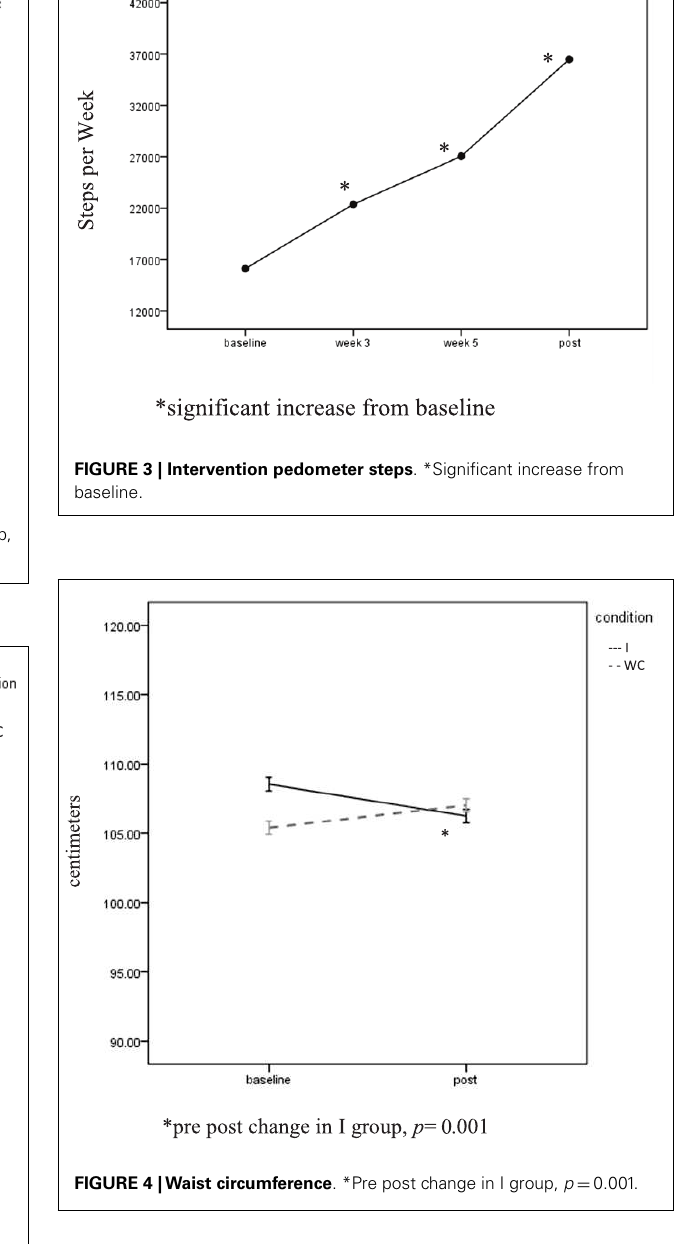
FIGURE 2 | Self-reported moderate physical activity . *Group difference, p = 0.03.